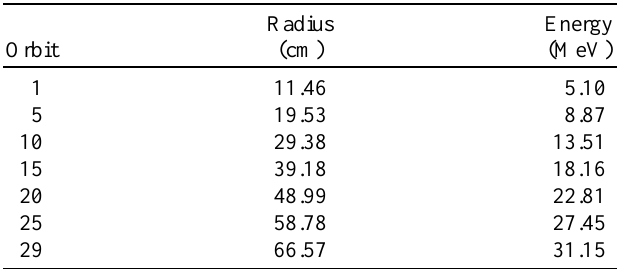
TABLE IV. Radius and energy of the orbits calculated with PTRACE